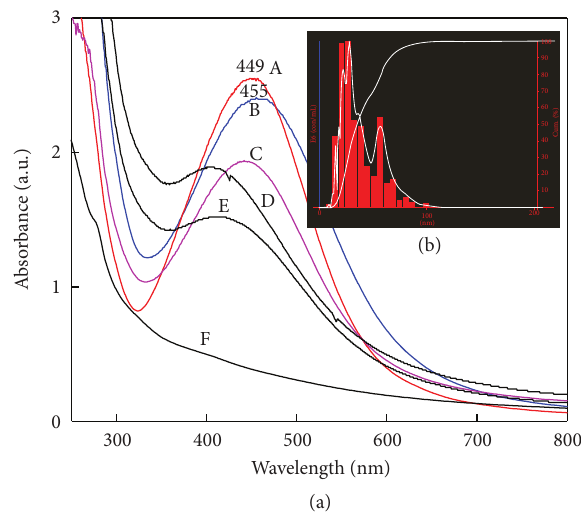
Figure 8: Effect of light intensity on SNPs synthesis. A: 750×100 lux (sunlight), B: 141.3lux (40Watt yellow light), C: 190.7lux (40Watt fluorescence light), D: in dark, E: 93.1 lux (UV light), and F: 15.5lux (15Watt light). (a) Sunlight (spectrum A) shows maximum sur- face plasmon absorbance which indicates the maximum synthesis (within 10min) and monodispersity of SNPs followed by 141.3lux lightintensity(spectrumB).Indark,morethan48 hrswererequired for complete reduction of silver ions. Particle size distribution by NTA of sample prepared in sunlight ((b) inset).